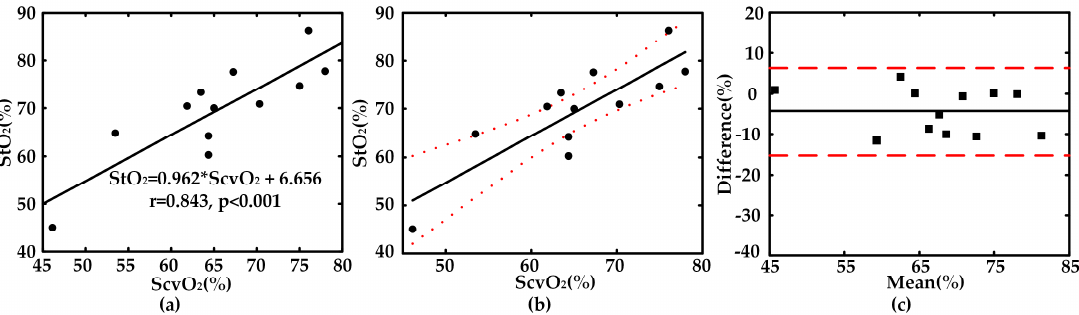
Figure 7. Comparison between StO 2 and ScvO 2 : ( a ) linear analysis; ( b ) 95% confidence interval for StO 2 (dot line); ( c ) difference plot and 95% limits of an agreement (dash line).